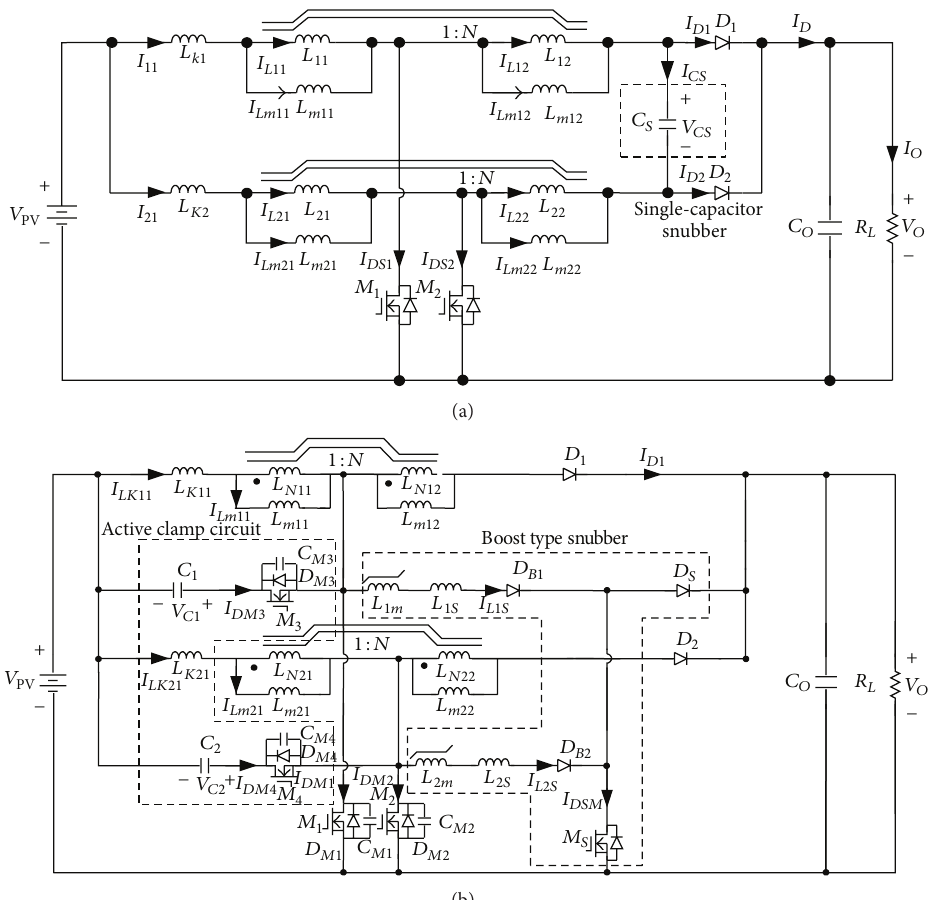
Figure 4: Schematic diagram of interleaved coupled-inductor boost converter (a) with a single-capacitor snubber and (b) with boost type